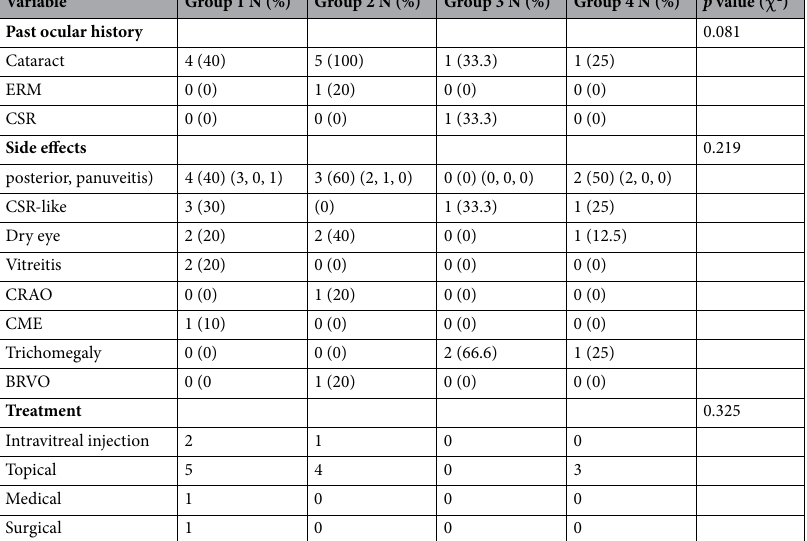
Table 4. Ocular and side effect characteristic of biological treatment mechanism groups. CSR, central serous retinopathy; CRAO, central retinal artery occlusion; CME, cystoid macular edema; BRVO, branch retinal vein